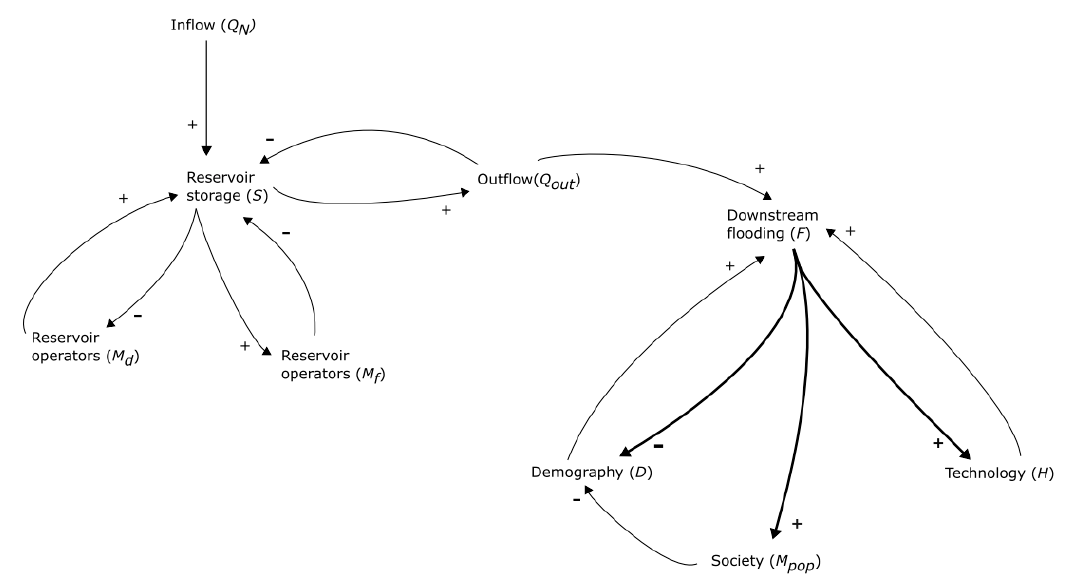
Figure 1. Loop diagrams showing the link between the reservoir module ( left ) and the flooding module ( right ), and connections between variables. Thin arrows indicate the gradual coevolution of variables over time, whereas thick arrows indicate abrupt changes when flooding occurs.